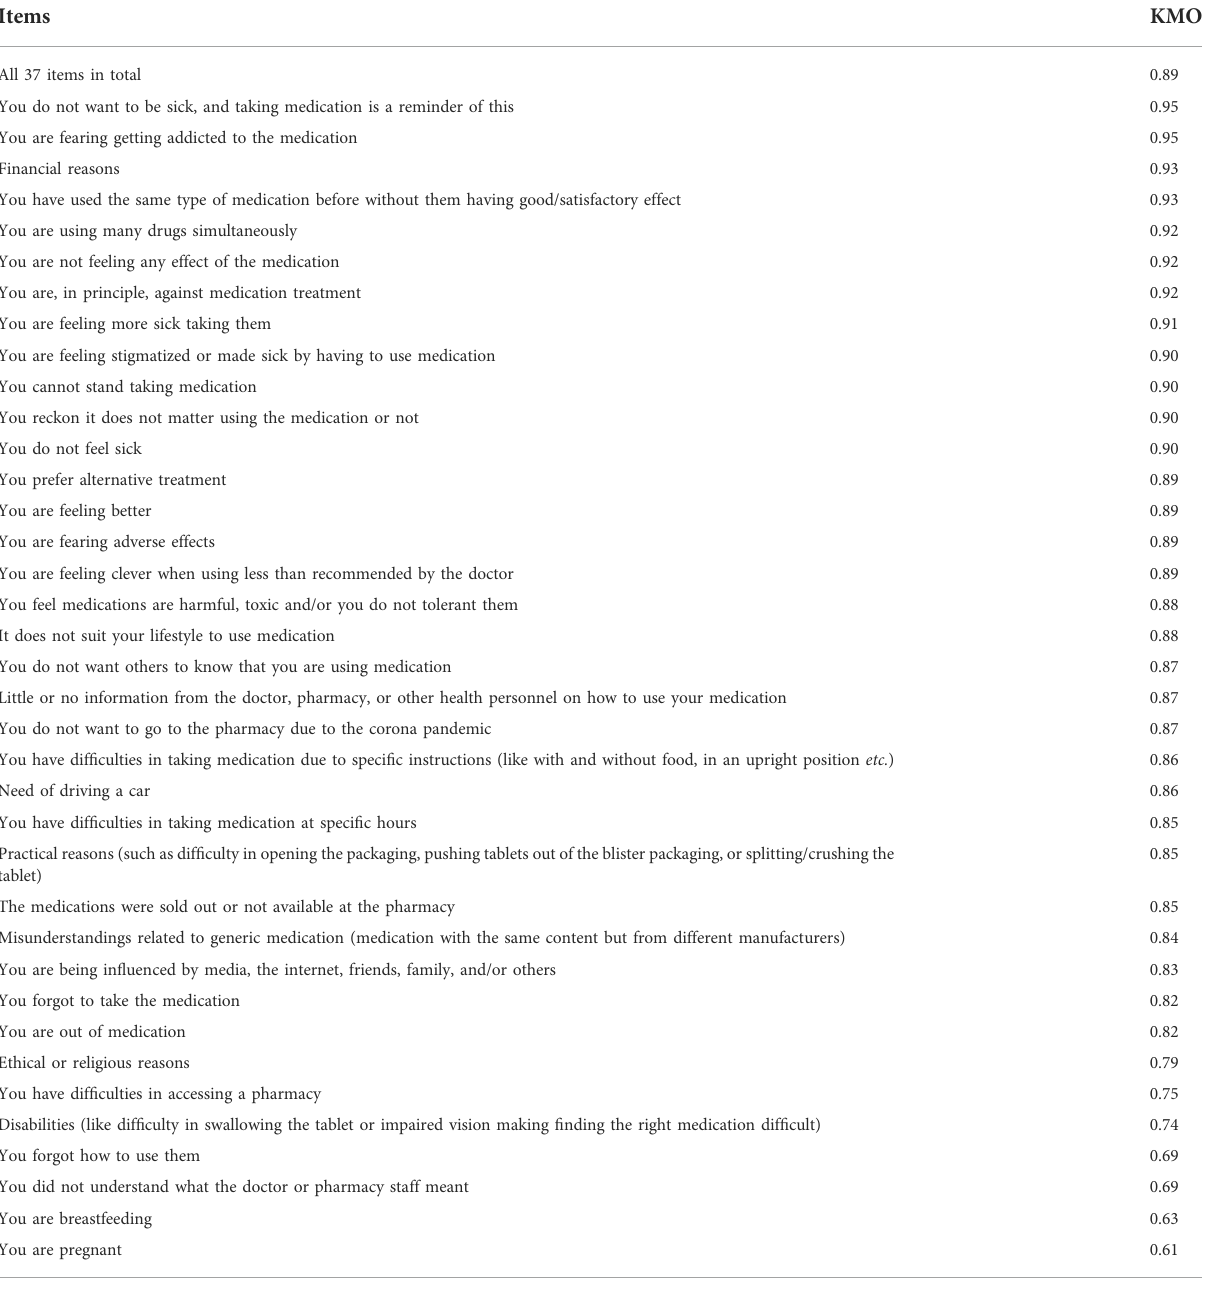
TABLE 3 Kaiser-Meyer-Olkin (KMO) values for each survey item. Items